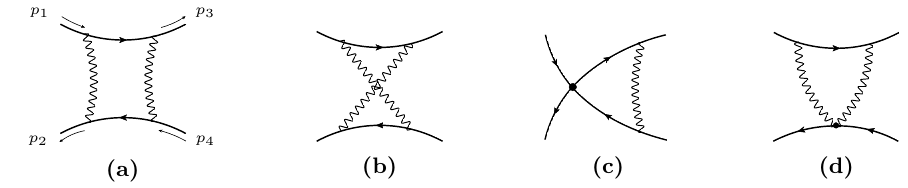
Figure 1 . (a) planar and (b) nonplanar one-loop box diagrams giving rise to the leading- power Glauber phase; (c) an e(cid:11)ective theory diagram giving rise to the power-suppressed